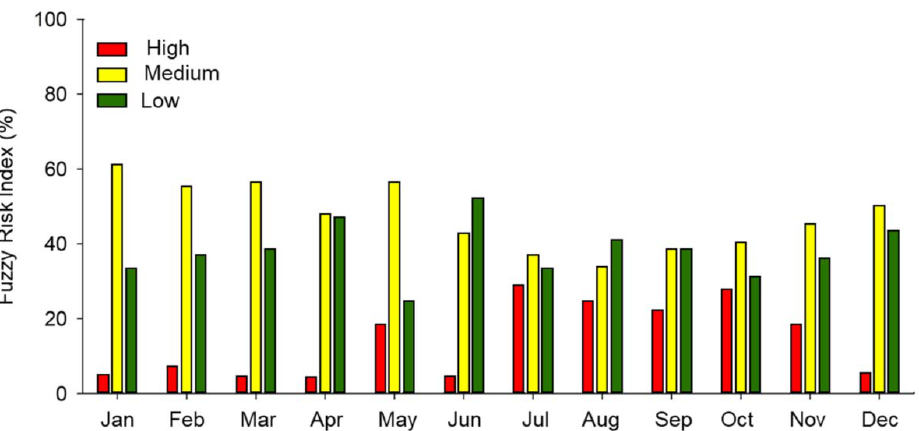
Figure 4. Fuzzy risk index classes (high, medium, and low) to the occurrence of eucalyptus rust ( Austropuccinia psidii ) in the state of Espírito Santo, Brazil, over the months of January to December (2006–2013).